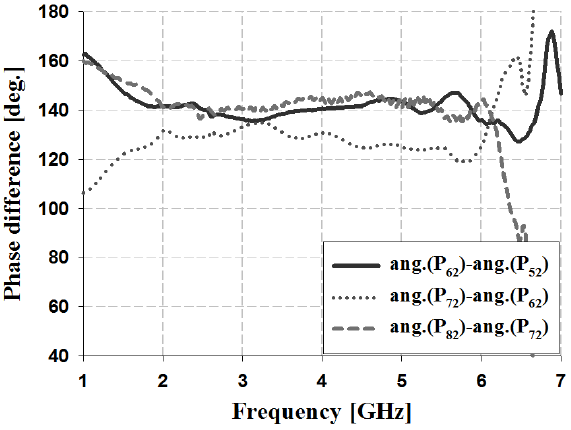
Figure 20. Measurement analysis of phase for input Port 2.